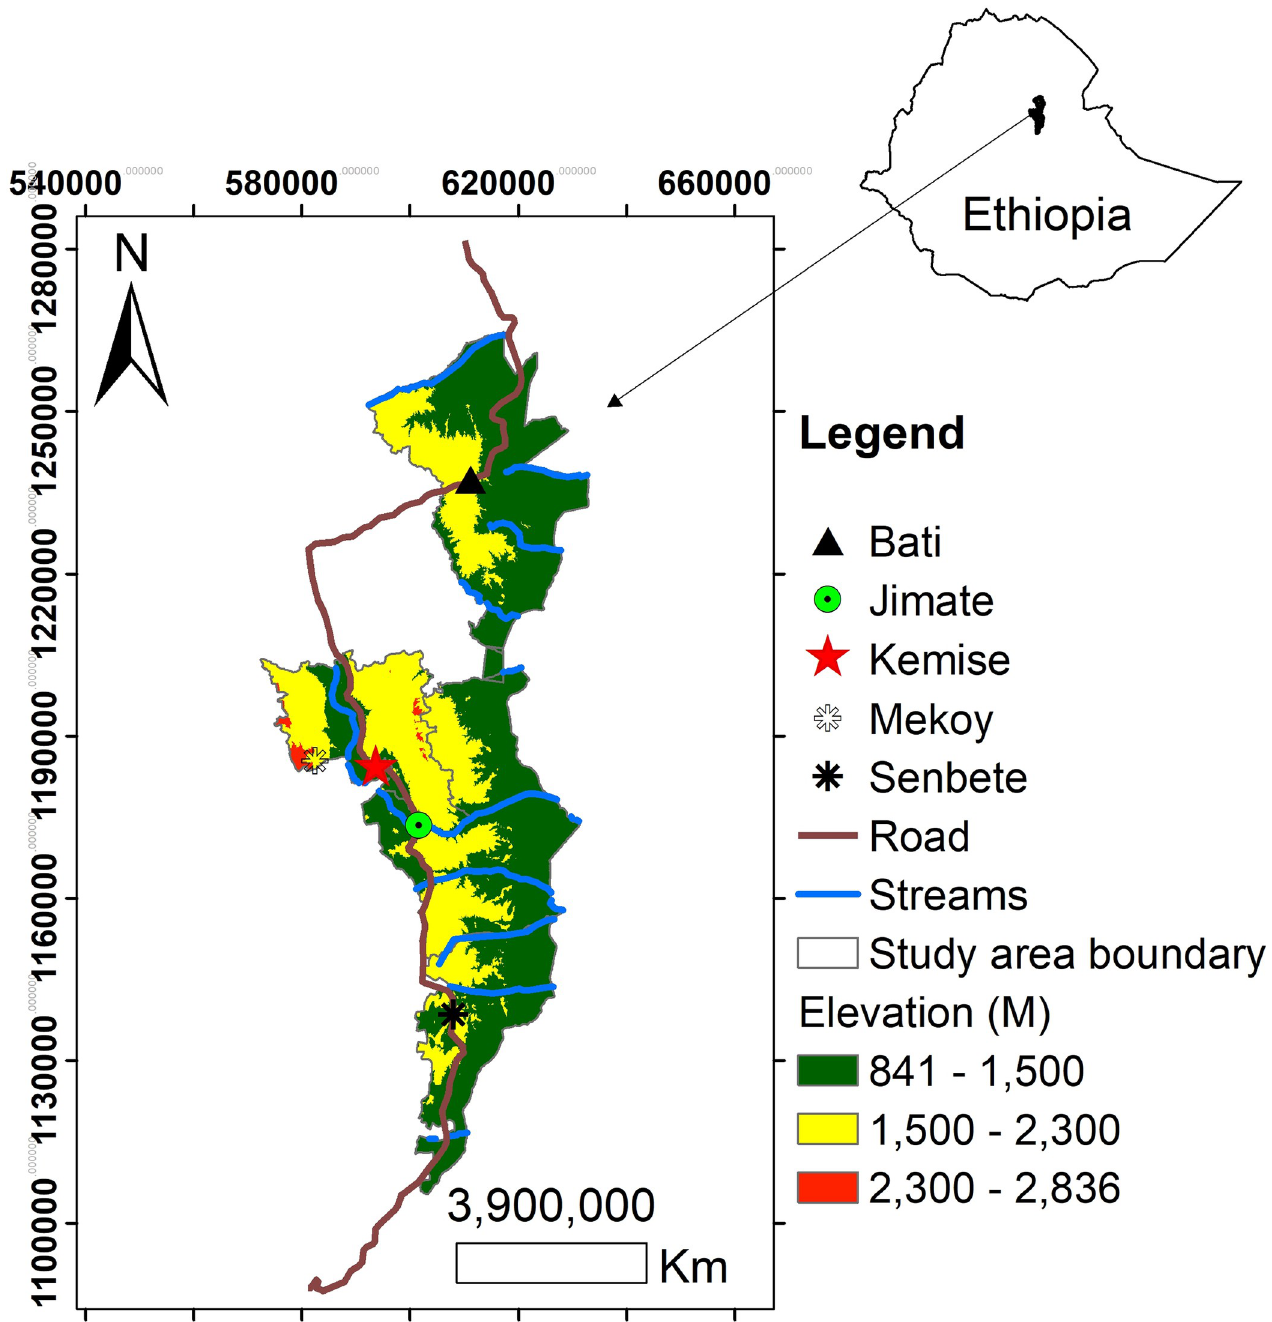
Fig 1. Location of the study